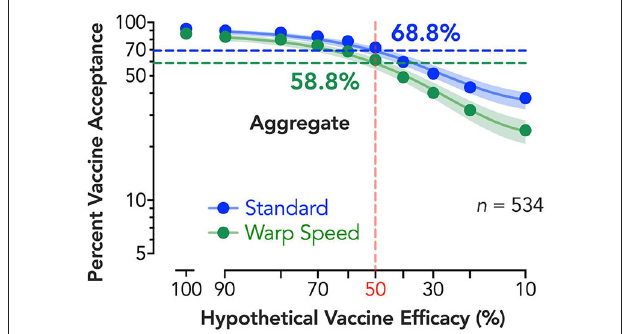
FIGURE 1 | Estimated percent vaccine acceptance by efficacy and vaccine development process. Vertical reference line (shaded red) depicts the FDA’s 50% vaccine efficacy target, with horizontal lines depicting the vaccine acceptance associated with 50% efficacy for both standard (shaded blue) and expedited (shaded green) development processes; adjacent numerical values indicate exact solutions for coverage at 50% per group (shaded, respectively). Shaded 95% confidence bands were generated using bias-corrected and accelerated (BCa) bootstrapped values based on 10,000 iterations. A corrected (for small numbers of data points) Akaike information criterion test indicates a > 99.99% probability the curves are best described independently (i.e., do not share best fit parameters in the nonlinear curve-fitting).